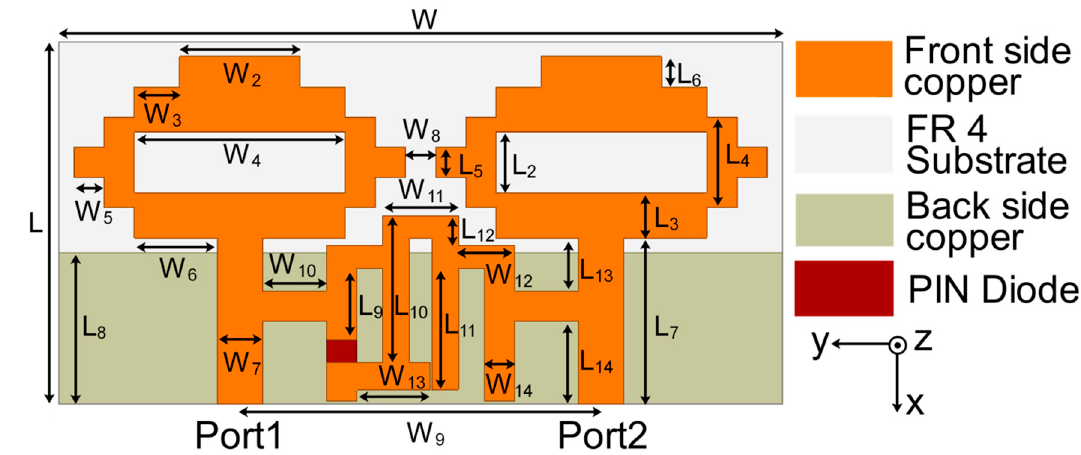
Figure 14. Complete two-port MIMO antenna structure with decoupling network.